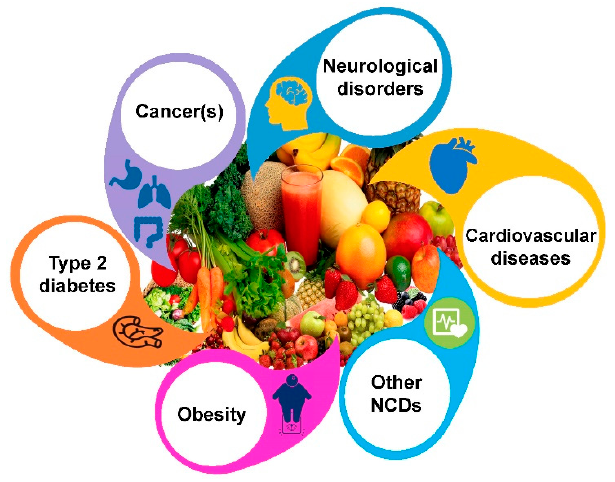
Figure 1. Main health benefits of polyphenols related to chronic